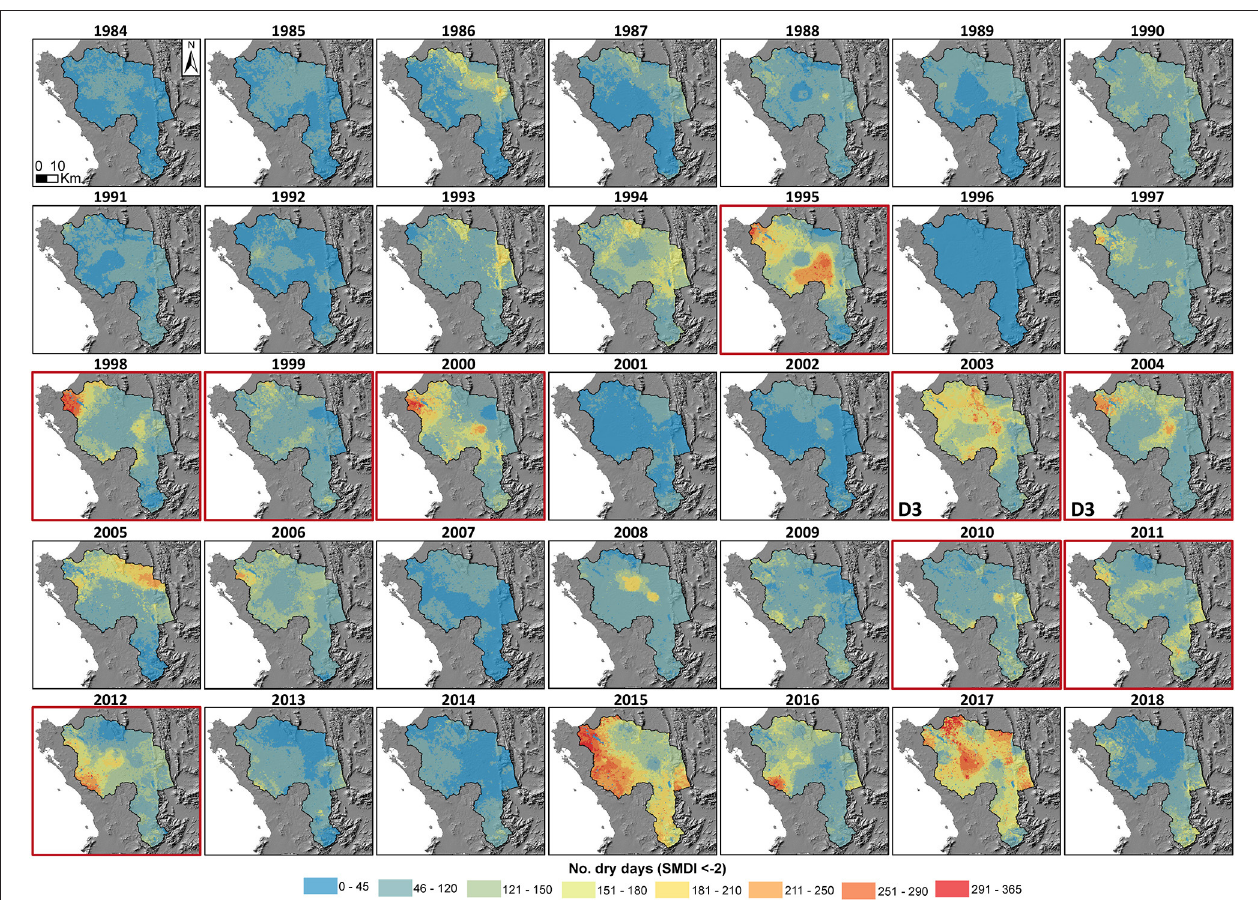
FIGURE 3 | The number of dry days where the simulated Soil Moisture Deficit Index (SMDI) was between − 2 and − 4 for the periods 1984–2018 for the Berg River catchment. Severely dry years included: 1995, 2000, and 2003/2004, where > 250 dry days were simulated for parts of the catchment. The droughts of 1995, 2000, and 2012 were influenced by prior dry years ( > 120 dry days). Unlike these droughts, 2003/2004 and 2015/2017 were preceded by wet years. While similarities between the onset of the 2003/2004 drought, the 2015/2017 drought was significantly drier and possibly influenced by anthropogenic water use (after Watson et al., 2022). Source: https://www.elsevier.com/about/policies/copyright.